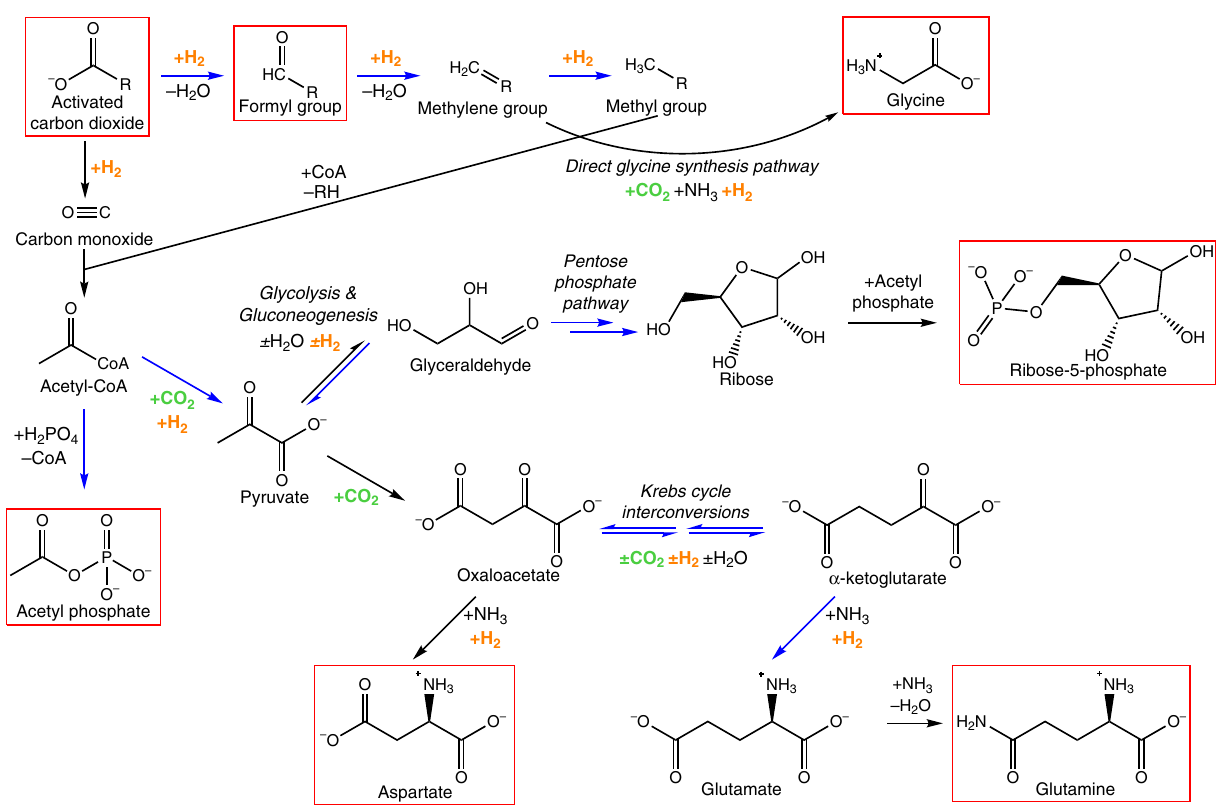
Fig. 1 Schematic of what could have been the beginnings of biochemistry. Main steps of core intermediary metabolism starting from CO 2 and H 2 , showing key intermediates in the acetyl CoA pathway, reverse incomplete Krebs cycle, reductive amination, gluconeogenesis and the pentose phosphate pathway. The precursors for nucleotide synthesis are boxed in red. Reactions shown in blue have been partially or completely achieved under prebiotic conditions. R denotes biological cofactors such as tetrahydrofolate; prebiotic equivalents could include mineral surfaces. Acetyl phosphate can phosphorylate ADP by substrate-level phosphorylation in bacteria and archaea, and under prebiotic conditions. Ribose phosphate is the precursor for phosphoribosyl pyrophosphate, used in all nucleotide synthesis. Importantly, CO 2 and H 2 equivalents are required at multiple